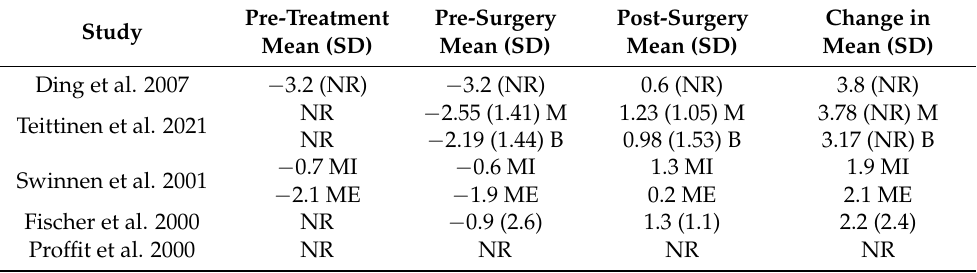
Table 10. The change in overbite measured on the incisors as a result of orthognathic surgery (mm).